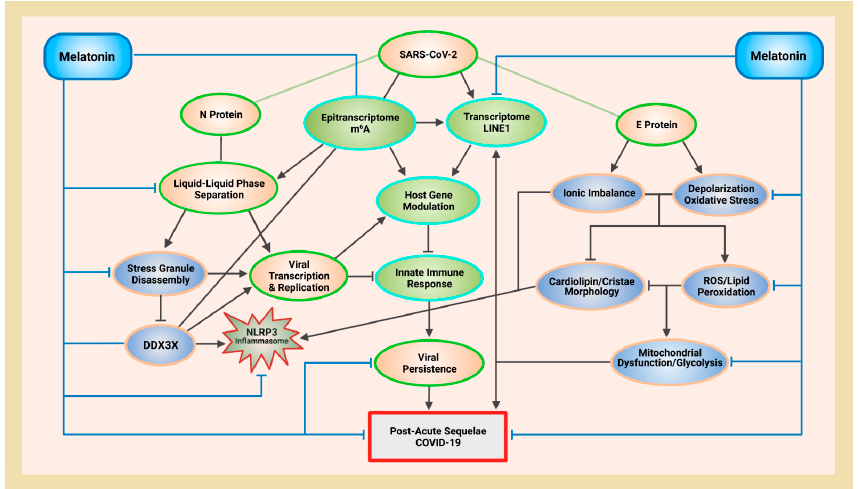
Figure 1. Schematic illustrating melatonin attenuation of acute infection, viral persistence, and post- acute sequelae COVID-19 (PASC) from potential alterations to the epitranscriptome and transcriptome via RNA m 6 A modifications and LINE1 derepression by the SARS-CoV-2 virus. The envelope (E) protein causes extensive mitochondrial distress and elevates oxidative stress via membrane depolarization and ionic imbalances that activate LINE1 derepression, NLRP3 inflammasome apoptotic signaling, stress granule formation, and nucleocapsid (N) protein liquid- liquid phase separation (LLPS). N protein LLPS forms membraneless condensates that not only facilitate viral transcription, genome packaging, and dissemination, but also enhance the suppression of host gene expression to evade innate immune responses via the disassembly of stress granules and the hijacking of DEAD-box RNA helicase DDX3X. Melatonin employs antioxidant- dependent and -independent strategies to modulate m 6 A modifications, suppress LINE1 derepression, rescue mitochondrial dysfunctions, and reduce oxidative stress. Melatonin regulates N protein LLPS to block the sequestration of DDX3X and the formation of NLRP3 inflammasome, as well as the disassembly of stress granules to support innate antiviral immune response, inhibiting viral transcription and replication, maintaining host gene stability and integrity to prevent severe disease and PASC (see Abbreviations for additional acronyms).